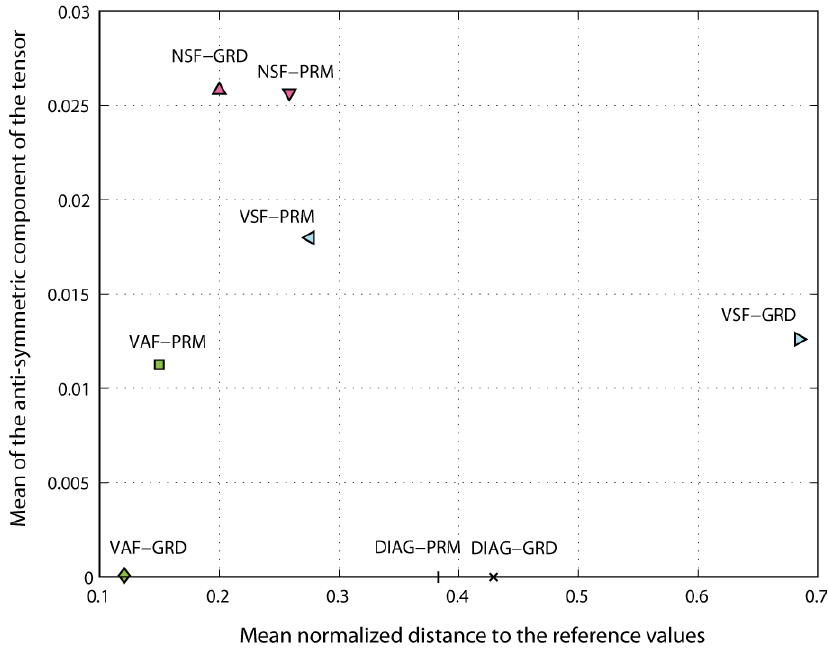
Figure 18. Synthetic representation of the comparison between the reference and the numerically estimated equivalent conductivity tensors, in terms of the degree of anti-symmetry. The abscissa of a point in this figure represents the average of the norm over the twelve 2D blocks of porous media defined in the text. The ordinate represents the mean degree of anti-symmetry, averaged over the twelve 2D media.